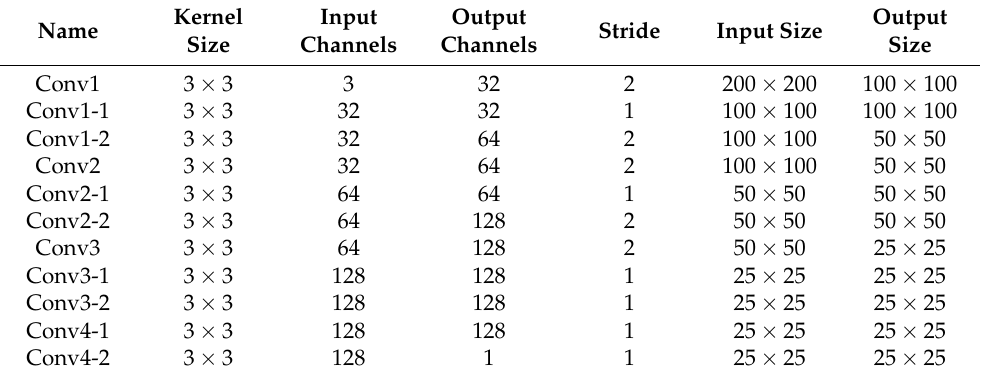
Figure 5. Proposed CNN architecture for respiration measurement. Table 2. Model parameter of the proposed motion-based respiration measurement CNN.